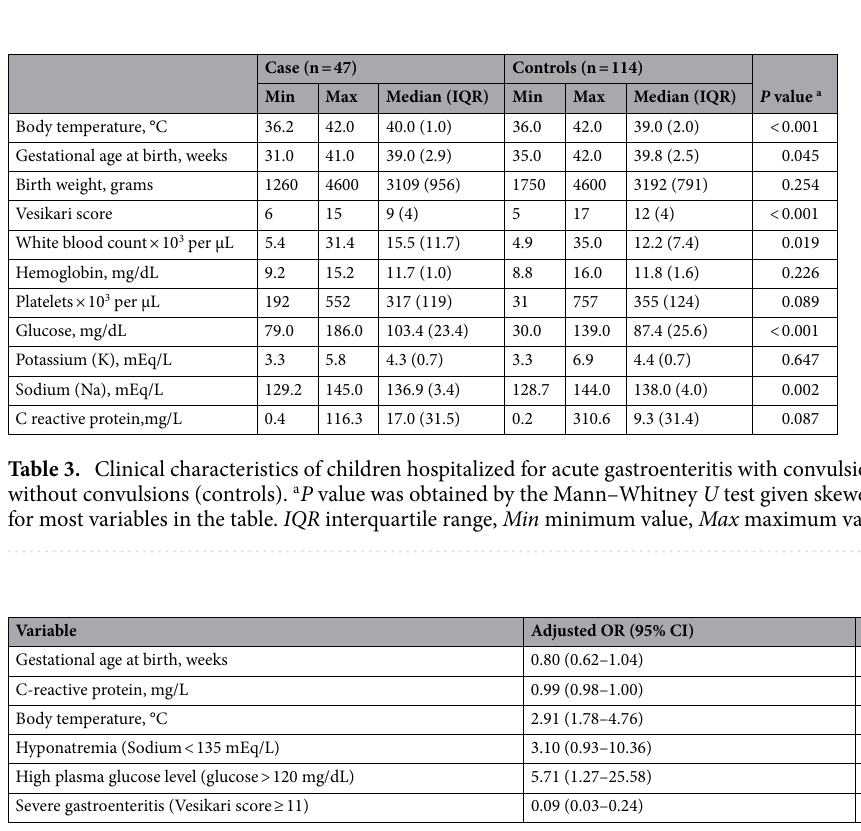
Table 4. Multivariable logistic regression model of the adjusted associations of clinical characteristics with convulsions in children hospitalized for acute gastroenteritis. CI confidence intervals, OR confidence